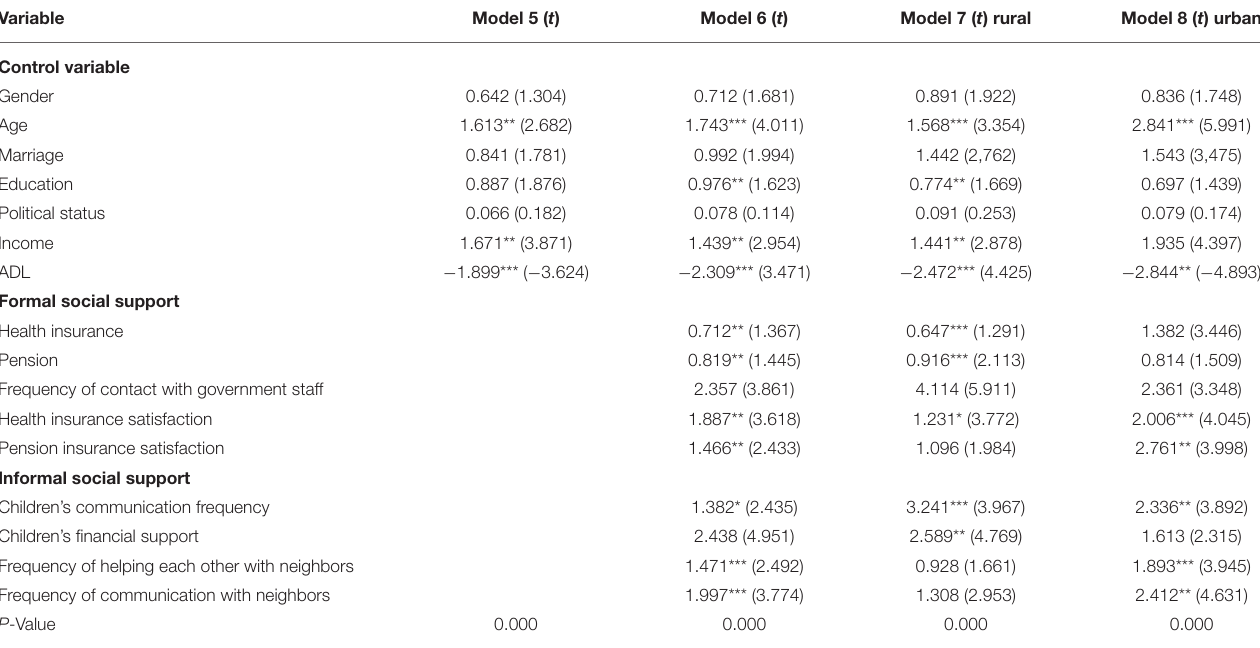
TABLE 5 | The impact of formal and informal social support on the utilization of inpatient healthcare services.